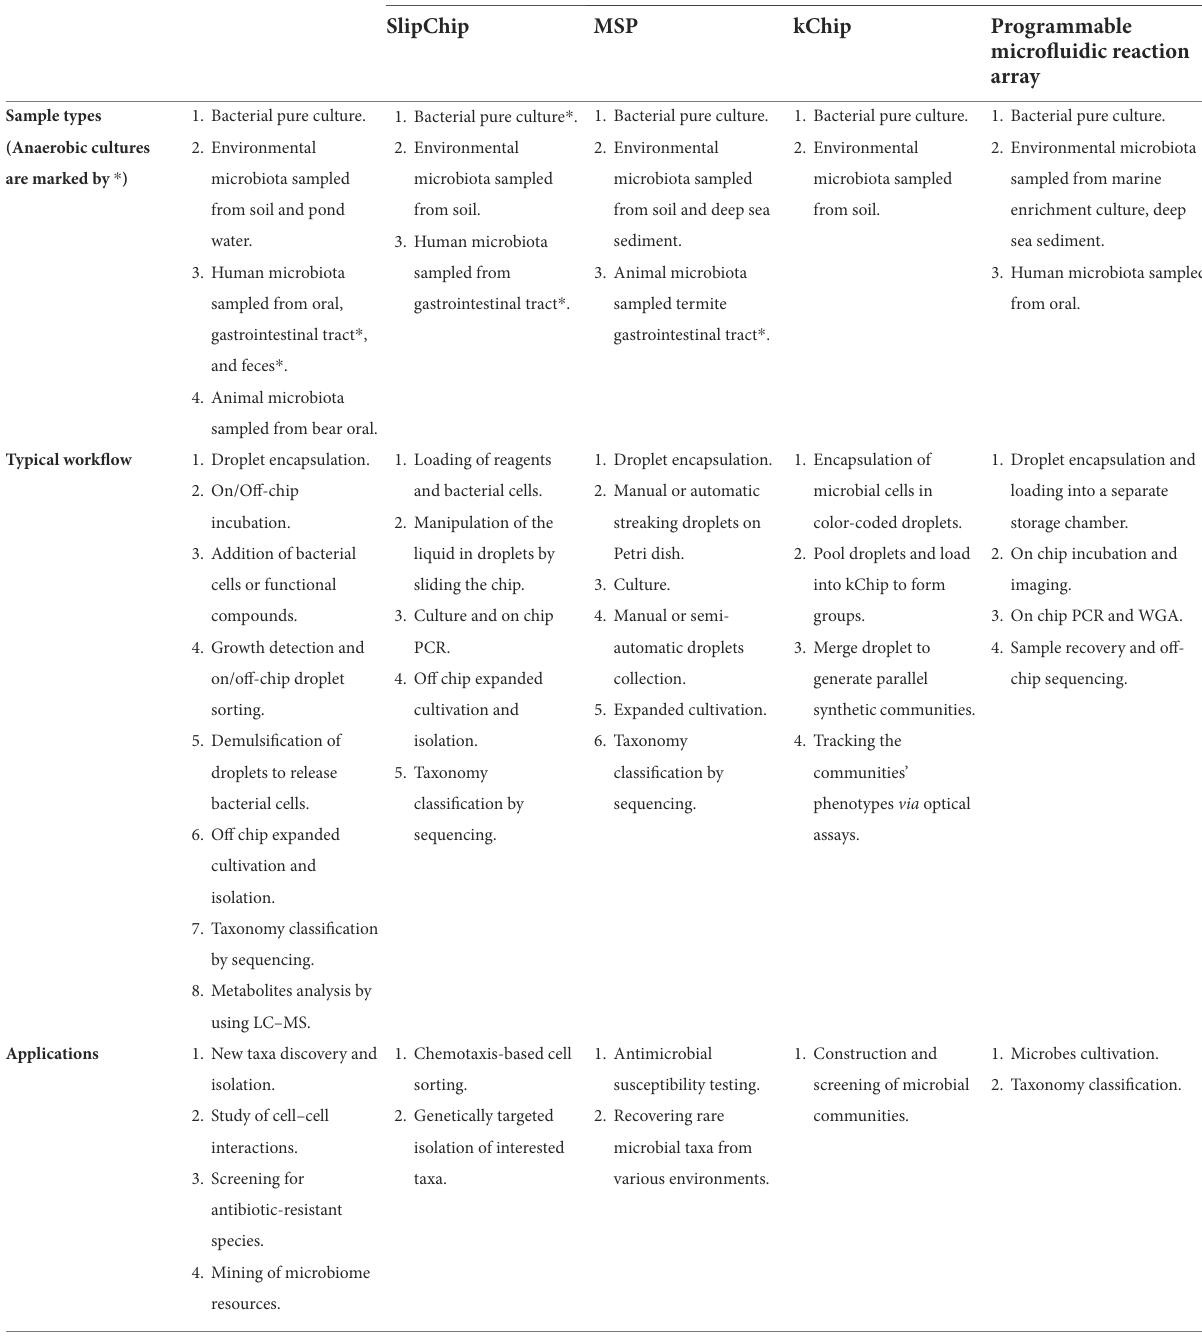
TABLE 1 A usage comparison of floating droplets and static droplets approaches. Floating droplets Static droplets SlipChip